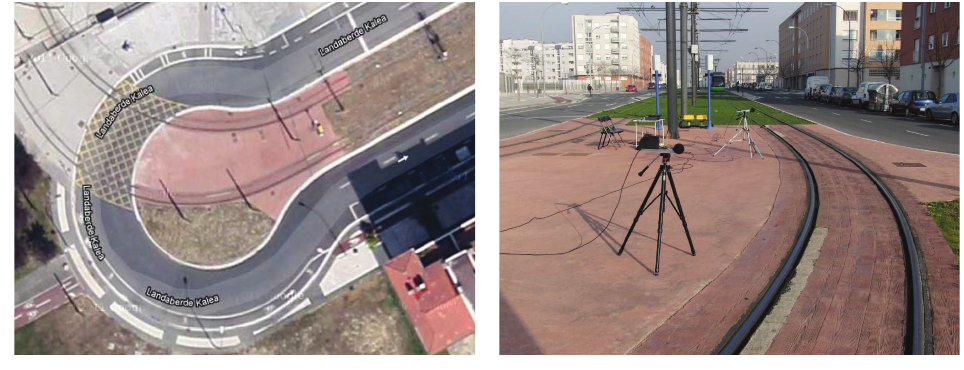
Figure 13: Track measurements.